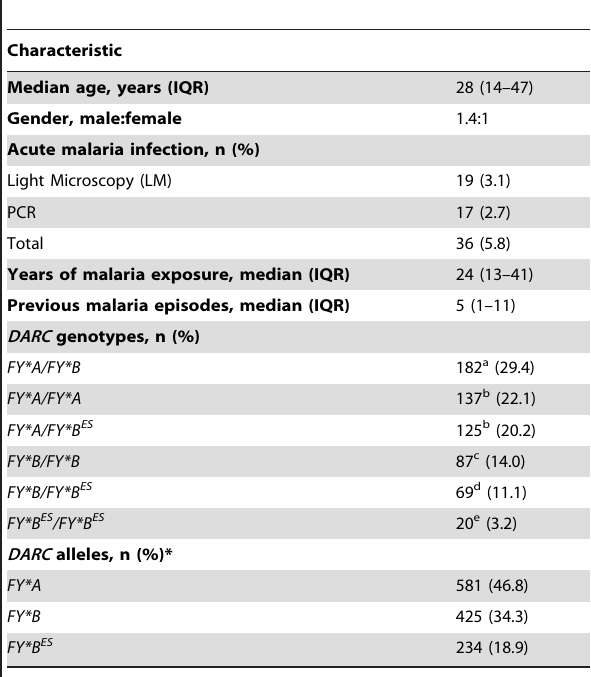
Table 1. Demographic, epidemiological and genetic data of 620 subjects, Rio Pardo Settlement, Amazonas,